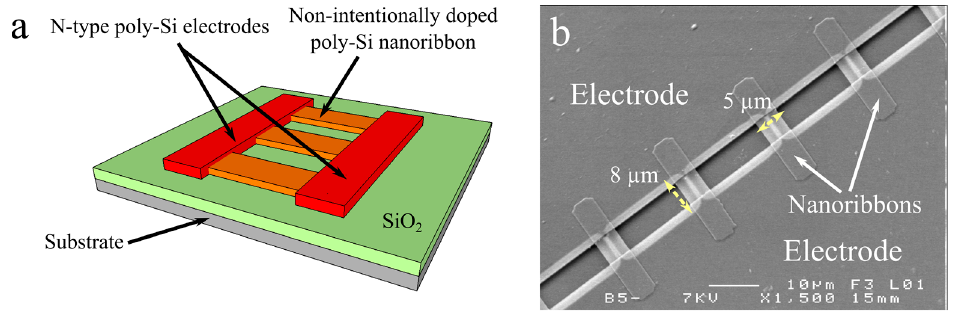
Figure 1. 3-dimensional s ketch of the resistor based on 500 parallel 50 nm-thick poly-Si nanoribbons ( a ) and SEM top view of the device ( b ) (geometric parameters: L = 8 μ m and W = 5 μ m for each